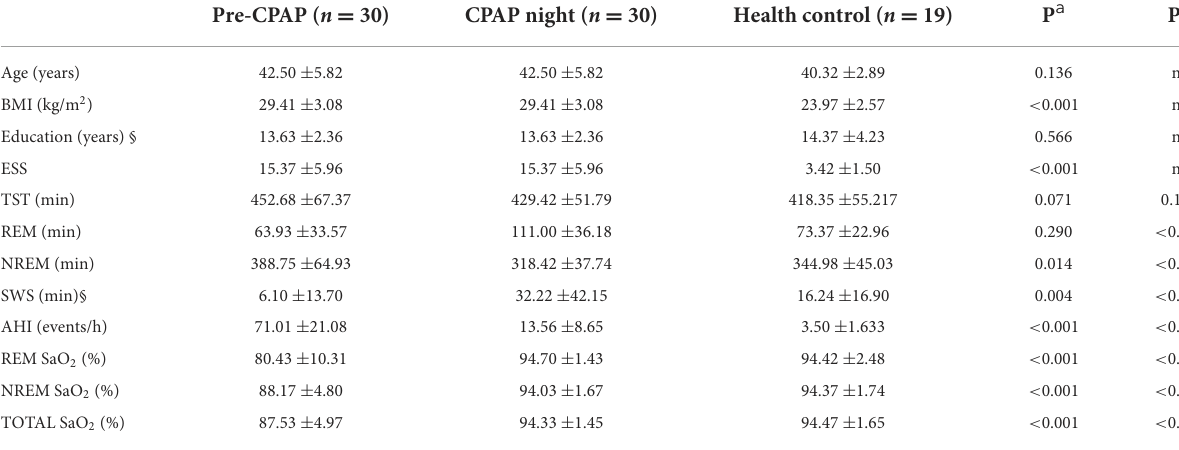
TABLE 1 Demographic and polysomnographic data of participants.